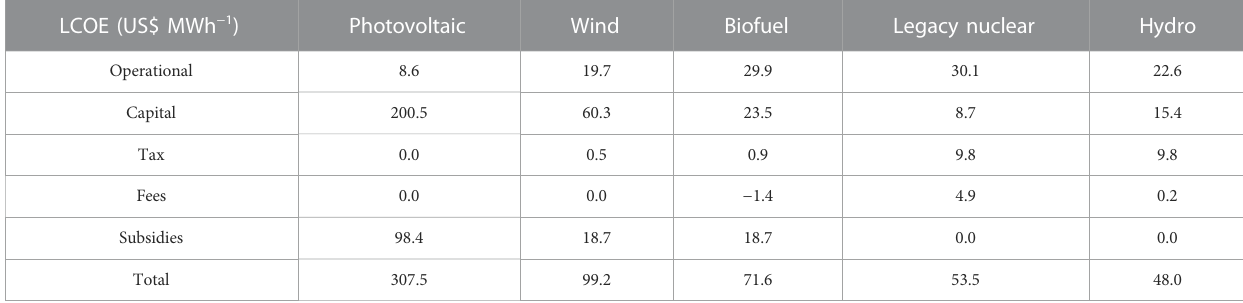
TABLE 1 LCOE by fuel